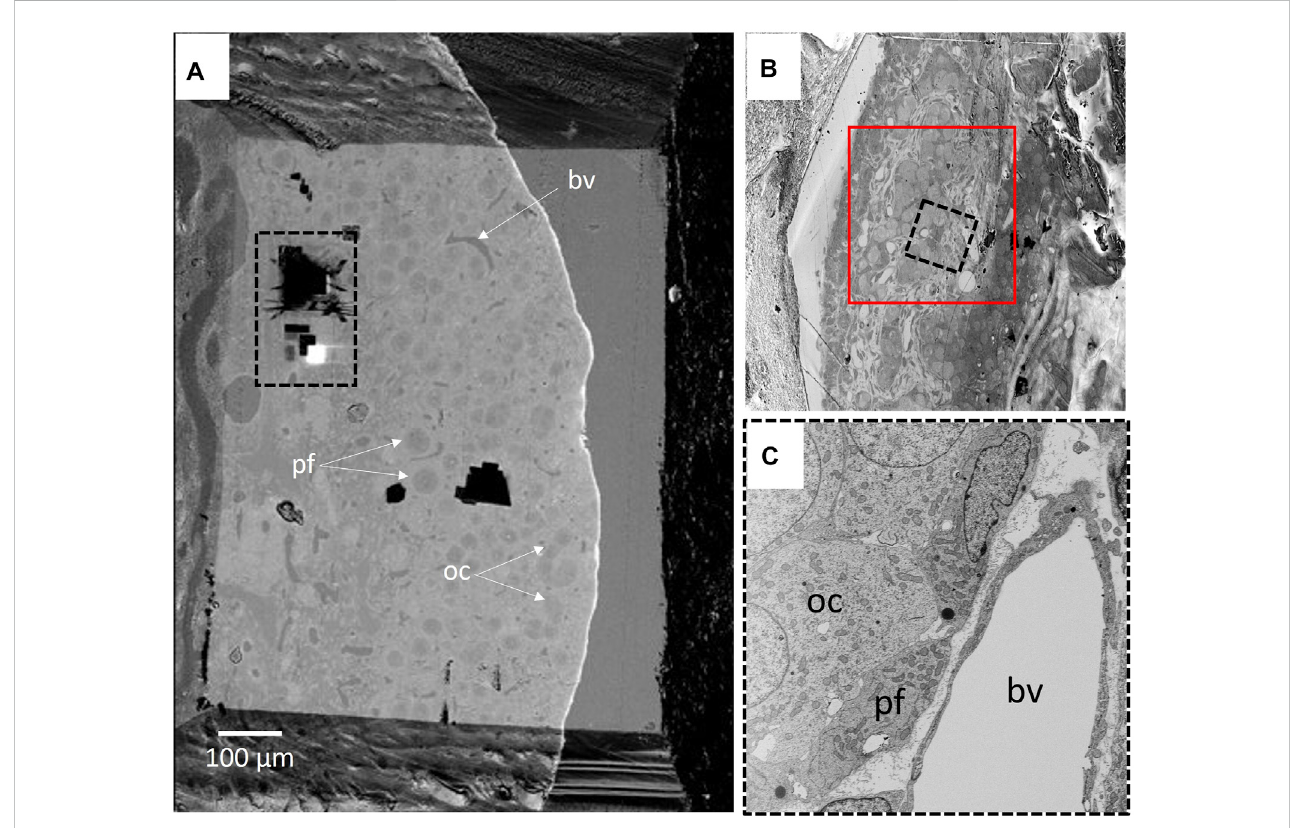
FIGURE 5 (A) BSD4blockfaceoverview,showingpartoftheovariancortexandpartofthemedullaryregion.Ovariancystsandprimaryfolliclesarevisible.Theblack dashed rectangle delineates the 3D run position shown in Supplementary Movie S2 (Supplementary Material). (B) The upper right inset shows the cortical regionoftheovariancortex(redsquare)onwhichtheareaofinterest. (C) Animageofthe3Drunregionisshowninthelowerrightinset.Oocyte(oc)andpre- follicular cells (pf) of an ovarian cyst were easily located. The blood vessel (bv) was taken as a point of